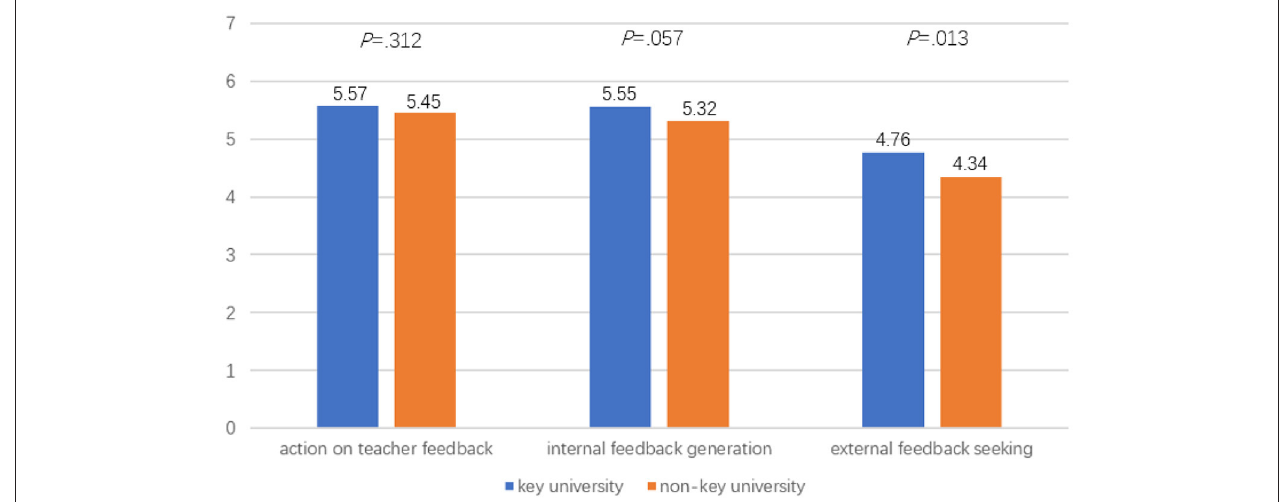
FIGURE 3 | Mean differences of feedback behavior between students from key and non-key university.